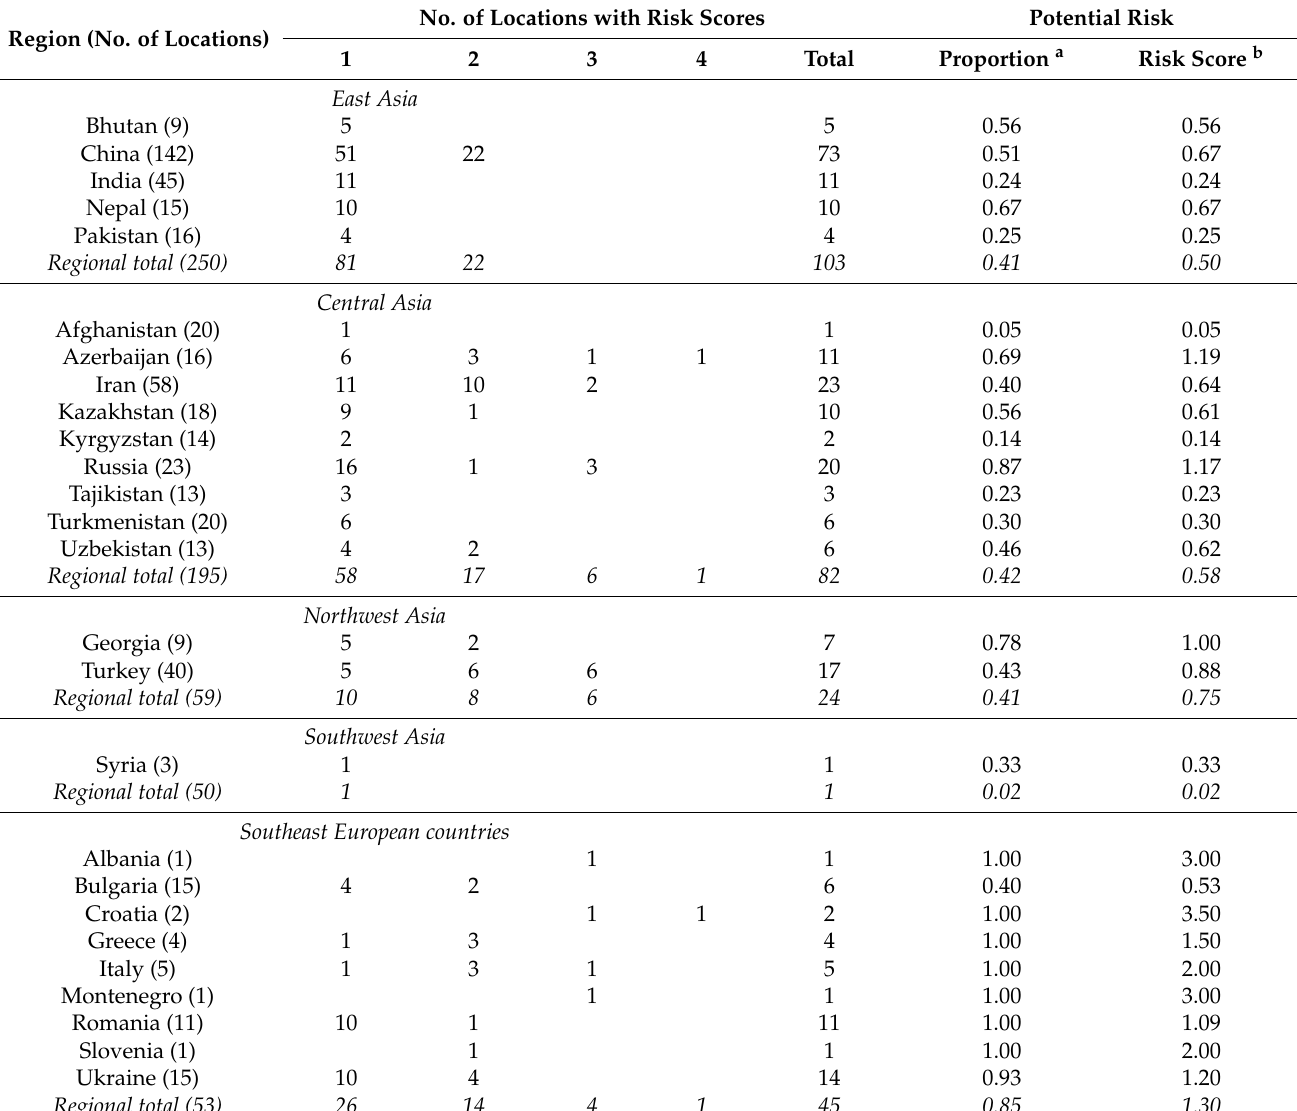
Table 1. Locations of potential infection risk from Puccinia striiformis f. sp. tritici in Asian and Southeast European countries. Region (No. of Locations)